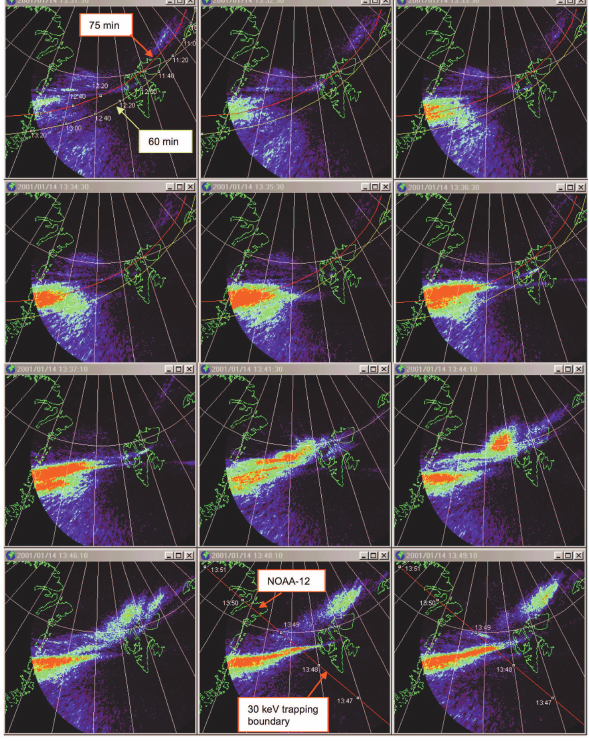
Fig. 8. A sequence of all-sky images of an 630.0-nm emission taken from Ny ˚Alesund, displayed on a geographical frame of reference, assuming an emission altitude of 250km. Emission intensity is colour-coded on a linear scale from blue to red. The red and yellow curves in the upper images represent the nominal ground-track of Cluster calculated for two different lags (75 and 60min) of the IMF observations. The straight red line west of Svalbard in the lower images represents the flight path of NOAA-12. The images show a progressive eastward expansion of the red line aurora toward Sval- bard, consistent with the reconfiguration of the convection pattern reported by Opgenoorth et al. (2001). (From Moen et al.,